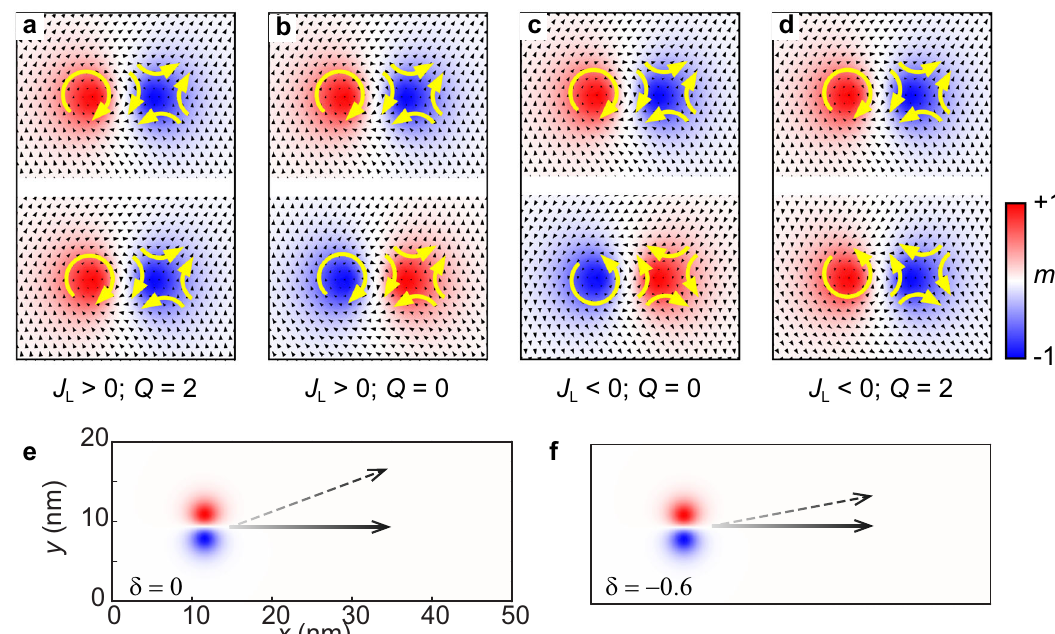
Fig. 6 The bilayer-bimeron texture in 3 R LaBr 2 bilayer. a – d is the four combination forms of bilayer-bimeron. e , f represent the top view of the system with δ = 0 ( J L > 0) and δ = − 0.6 ( J L < 0), respectively. The solid and dotted line represent the trajectory of bilayer bimeron with Q = 0 and Q = 2